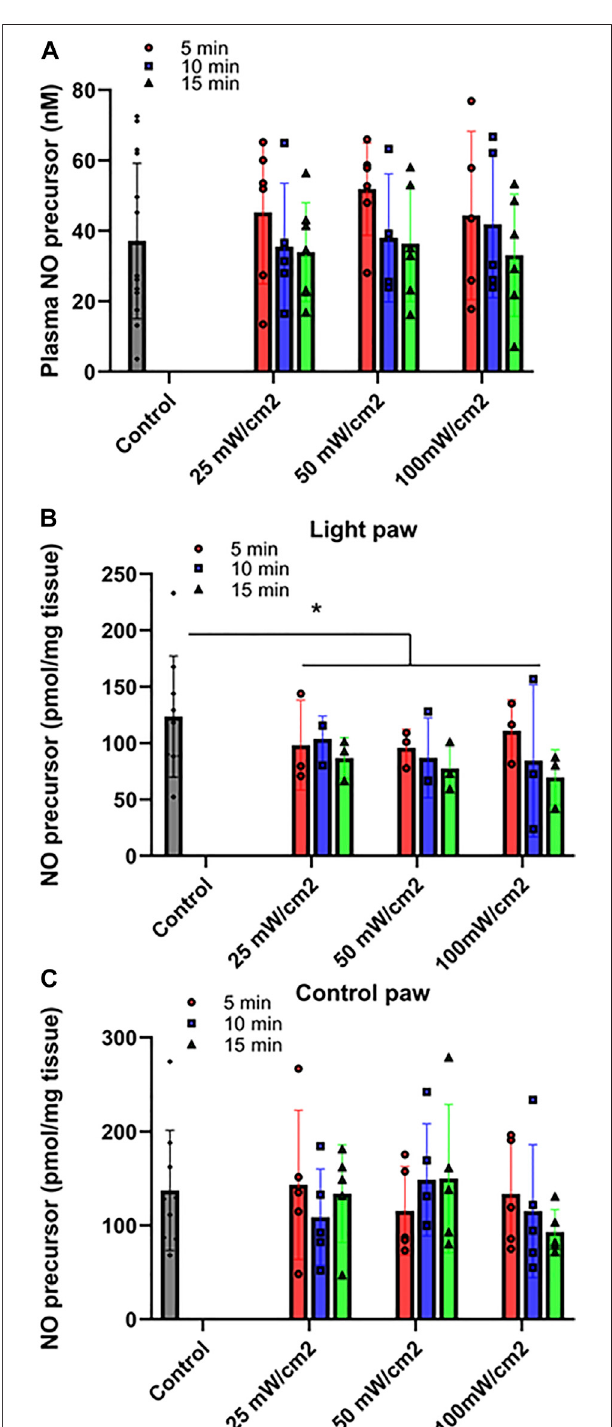
FIGURE 2 | Release of NO precursor species at varying power of red light. Ozone-based chemiluminescence analysis was carried out with triiodide-dependent chemiluminescence in plasma (A) , Quadriceps muscle treated with light (B ) or control limb (C) . Mean ± SD is denoted. (A) : No statistical signi fi cance was detected between the irradiated and control group ( p = 0.6108). (B) : The difference is signi fi cant between the irradiated